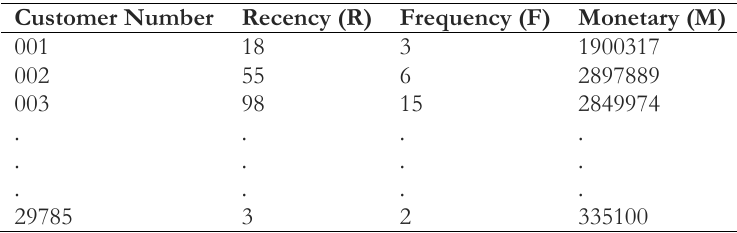
Table 1. Calculating the variables amount of